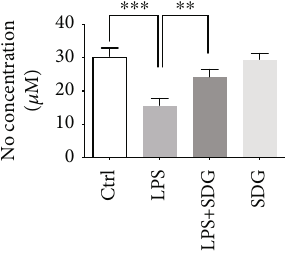
Figure 3: E ff ect of SDG on NO secretion in LPS-treated HUVECs. (a) SDG increased NO secretion in LPS-treated HUVECs. Error bars represent mean ± s : d . ∗∗ and ∗∗∗ represent p < 0 : 01 and p < 0 : 001 , respectively. All experiments were performed in triplicate. LPS: lipopolysaccharide; SDG: secoisolariciresinol